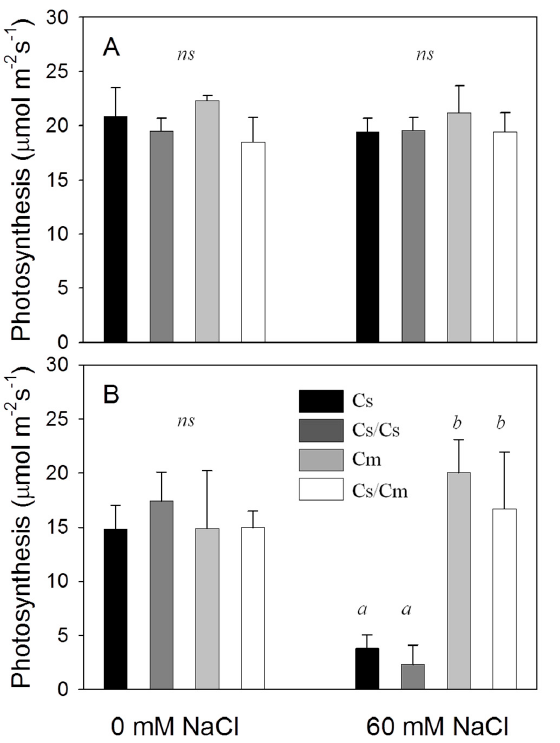
Figure 4. Effects of grafting and salinity on leaf photosynthesis rate measured on the youngest fully expanded leaves in experiment 2 on ( A ) 1 DAS and ( B ) 16 DAS ( n = 4). Four graft combinations are cucumber without grafting (Cs), pumpkin without grafting (Cm), cucumber grafted onto pumpkin (Cs/Cm), and self-grafted cucumber (Cs/Cs). Means followed by the same letter are not significantly different at p = 0.05 according to the Tukey Honest Significant Differences test.